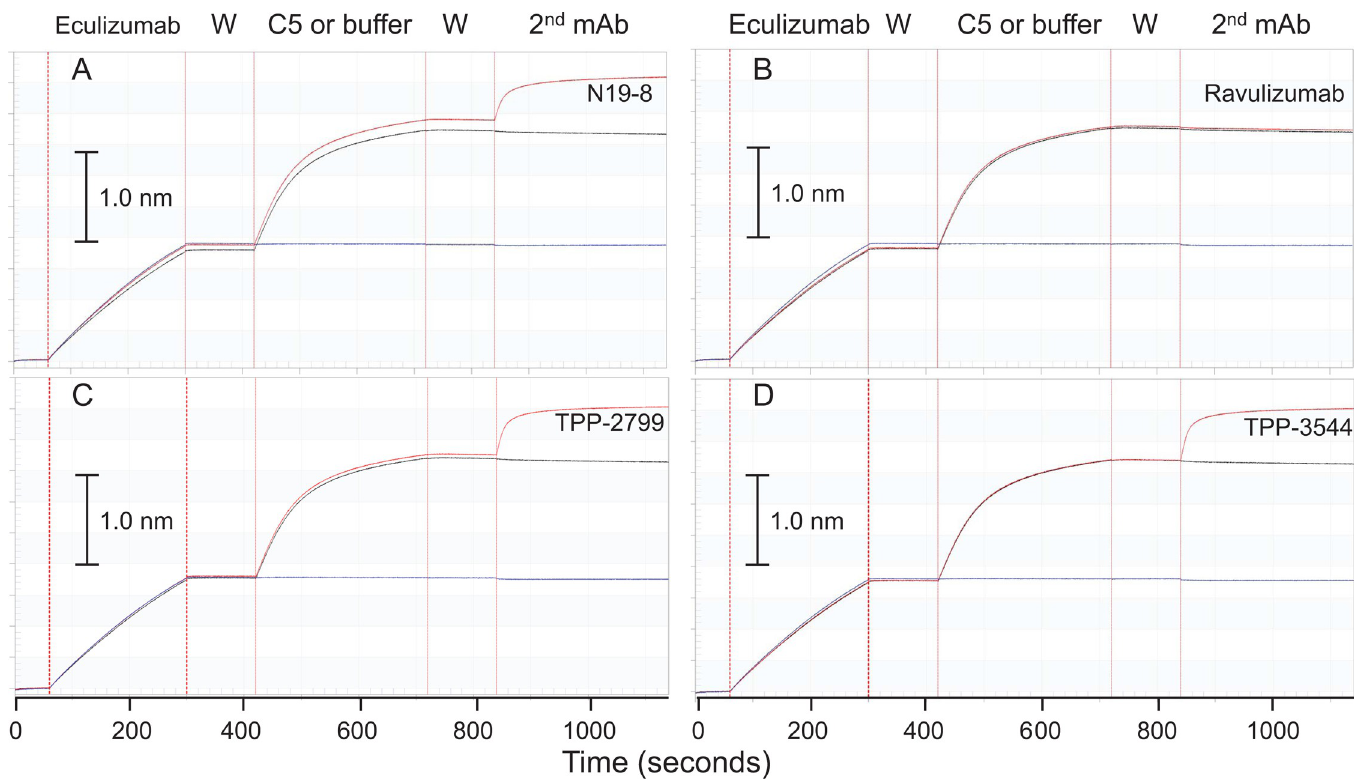
Fig 2. Recombinant anti-C5 mAbs TPP-2799 and TPP-3544 bind to hC5 noncompetitively with eculizumab. Biotinylated eculizumab was captured onto a streptavidin-coated biosensor probe, washed (W), and treated with either purified hC5 (red and black traces) or buffer (blue traces). Following an additional wash, probes were treated with either eculizumab (black traces), buffer (blue traces), or one of the following mAbs (red traces): (A) N19-8, (B) laboratory grade ravulizumab, (C) TPP- 2799, (D) TPP-3544. The scale bar shows the deflection corresponding to a biosensor signal of 1.0 nm. Abbreviations: C5 = complement component 5; mAb = monoclonal antibody; W =